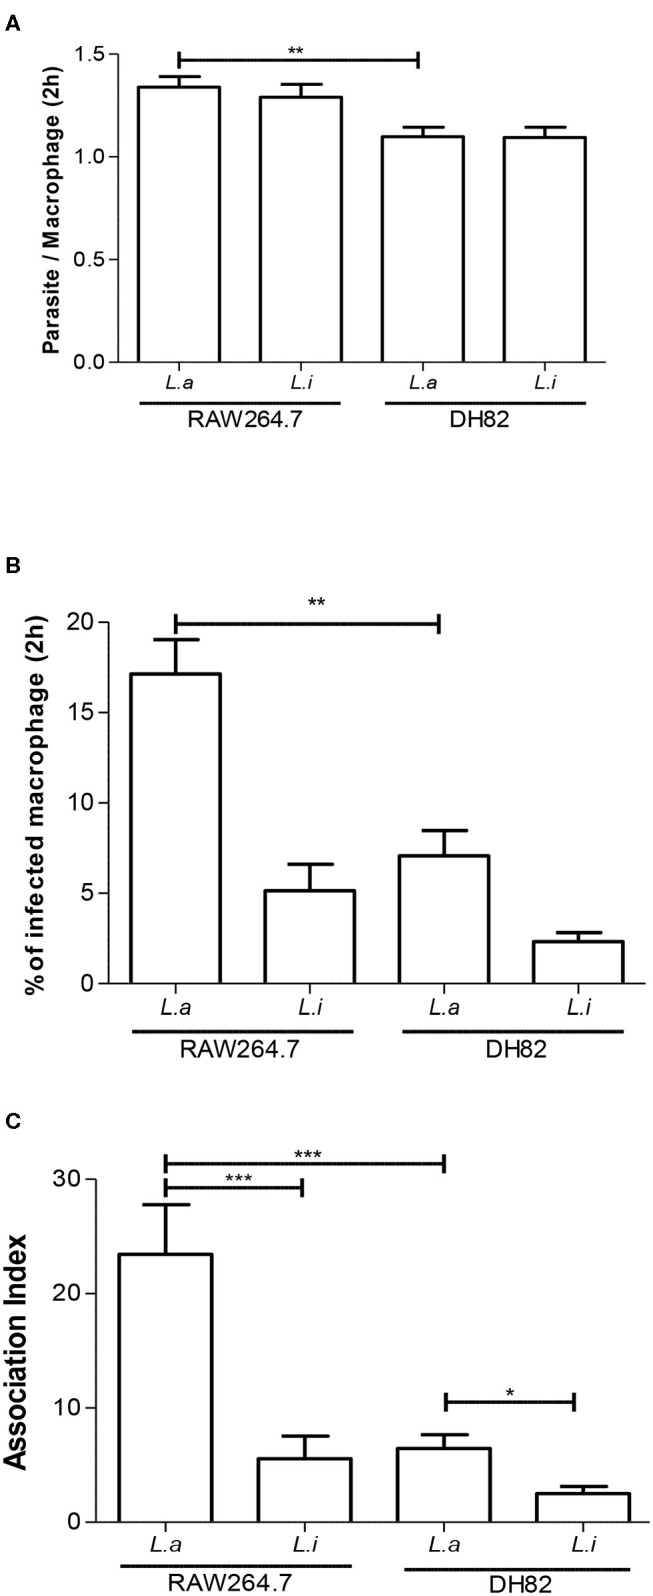
Association index of Leishmania in macrophages. Parasite per macrophages (A), % infected macrophages (B), and association index (C) in canine DH82 and murine RAW264.7. Macrophages were incubated with L. amazonensis (L.a) and L. infantum (L.i) promastigotes (5 parasites: 1 macrophage) for 2 h. The data represent mean ± SEM of three independent experiments done in triplicates. ***p < 0.0001; **p = 0.0093; *p = 0.005.